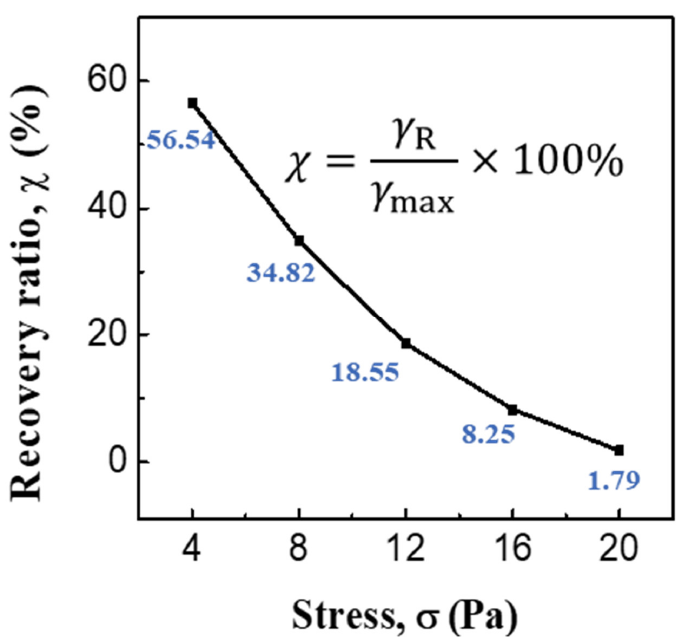
Figure 14. Recovery ratio vs. stress of GO/PDPA microsheet composites-based ER fluid (10 vol.%).